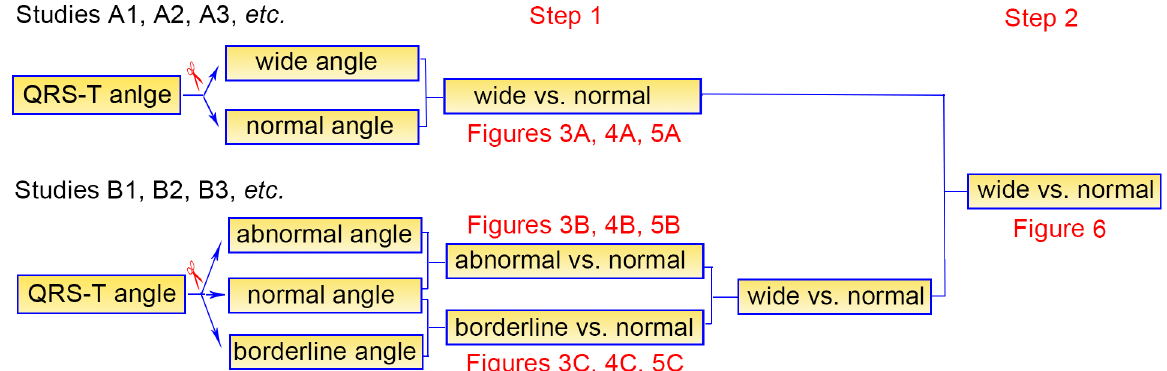
Fig 1. An overview of the 2-step analysis strategy in our